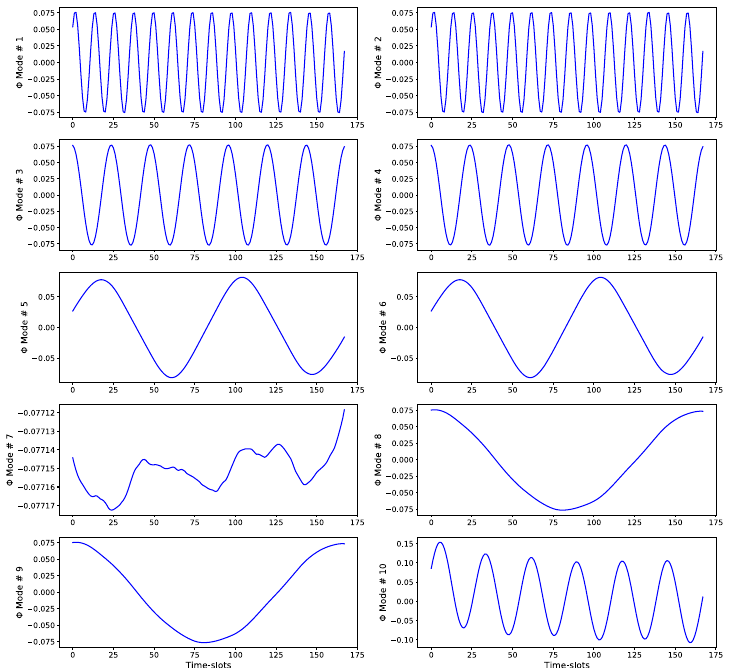
Figure 16. Principal eigenvectors ( Φ ) of the DMD algorithm (best linear mapping) for the temporal evolution of the load values. The eigenvectors are in order of importance (according to their corresponding eigenvalues) and represent the main modes of temporal evolution of the time-series. They clearly show the strong daily periodicity of the load values. The values shown correspond to a rolling window of 168 h (1 week).